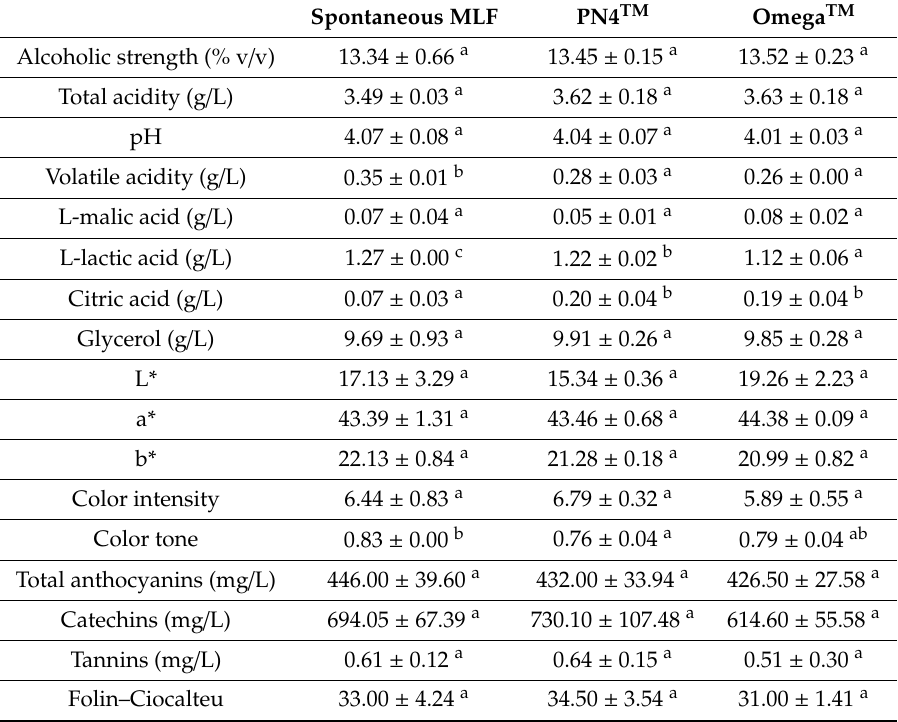
Figure 2. Progression of L-malic acid consumption (g / L) during vinification of Tempranillo must in the two samples inoculated with LAB PN4 TM ( (cid:7) ) and with LAB Omega TM ( (cid:4) ) at the beginning of the alcoholic fermentation and the uninoculated one ( • ). Data represented correspond to mean values obtained from duplicate fermentations; in all cases standard deviation was < 1.5. Table 1. Physicochemical parameters, organic acid concentrations, and color values of wines. Data represented correspond to mean and standard deviation values obtained from duplicate vinifications. Characters a, b, and c mean significant di ff erences at p <